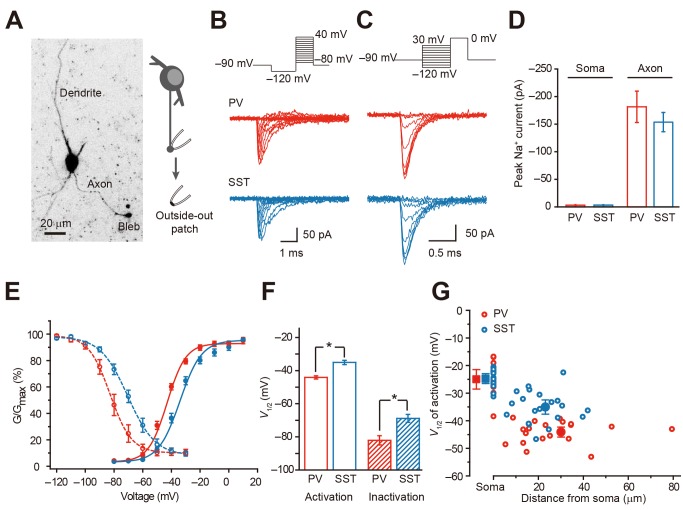
Difference in voltage dependence of axonal Na+ channels.(A) Projection of two-photon z-stack images of a GFP-positive PV neuron (left, black/white inverted). Note the axon bleb. (Right) Schematic diagram of the outside-out recording from patches excised from axon blebs. (B and C) Example current traces evoked by activation and inactivation voltage commands in PV and SST axonal patches. (D) Group data showing no significant difference in peak amplitude of axonal Na+ currents. However, in both types of neurons, the peak amplitudes of Na+ currents in outside-out patches of the axon were much greater than those in the soma. Error bars represent s.e.m. (E) Activation and availability curves for axonal Na+ currents. (F) Comparison of V
1/2 of activation and inactivation in the two cell types. * p<0.05. Error bars represent s.e.m. (G) The V
1/2 of activation was plotted as a function of recording distances from the soma. The average V
1/2 (±s.e.m.) of somatic and axonal Na+ currents is shown for comparison.